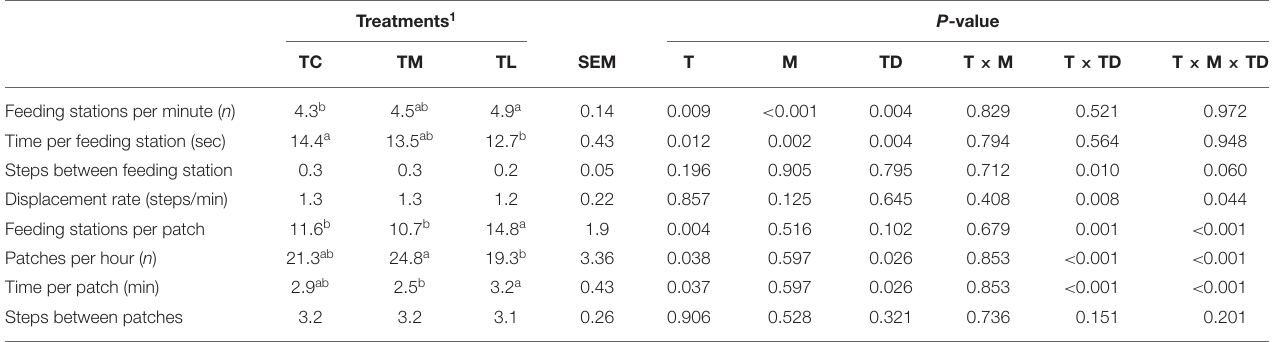
TABLE 4 | Effect of post-grazing sward height (T), moment of occupation period (M), and time of the day (TD) on displacement pattern and exploration of feeding stations and patches by lactating cows. Treatments 1 P -value